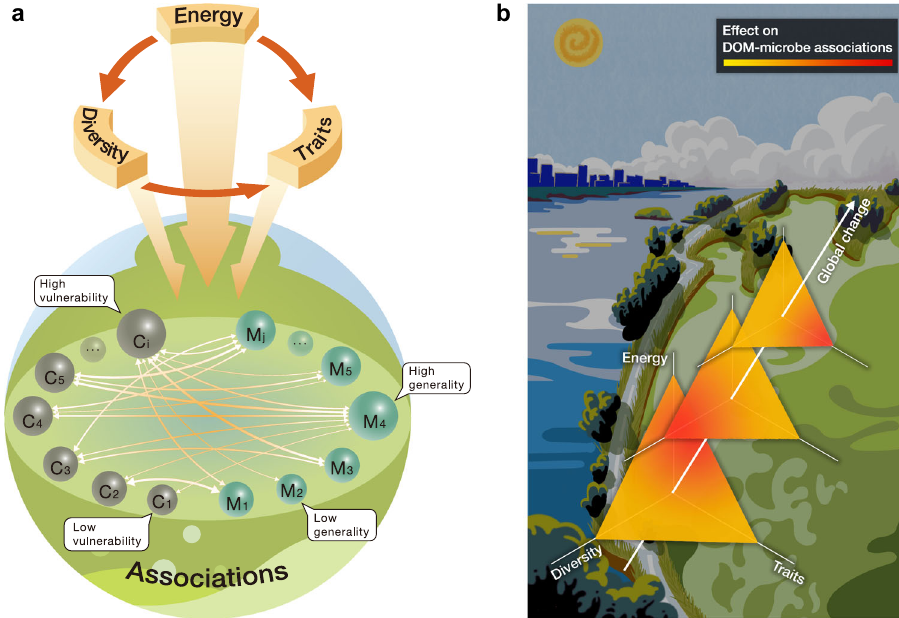
Fig. 1 A framework for studying the effects of global change on DOM-microbe associations. a DOM-microbe associations are affected by the three proximal drivers, namely energy supply and both the diversity and traits of DOM and microbes. The relationships among the three drivers and their in fl uences on the associations are shown with single-sided arrows. The DOM-microbe associations, indicated by double-sided arrows, are measured by bipartite interactions between DOM molecules (circles C 1 – C i ) and microbial taxa (circles M 1 – M j ). The size of circles indicates the abundance of DOM molecules or microbial species, and the width of arrows is the magnitude of associations. Commonly used indices summarise the specialization of individual molecule i and microbial species j , which describes the levels of “ vulnerability ” of DOM molecules and “ generality ” of microbial species. b Conceptual framework for understanding DOM-microbe associations under distal drivers such as global change via the three proximal drivers. For better 3D visualization, the sizes of triangles decrease towards the top-right, and the colour changes towards different corners of the triangles represent variations in the relative importance of different proximal drivers under a global change scenario. The background depicts the primary motivation of this study in examining distal drivers of climate change and eutrophication in Taihu Lake, China. The left and right waters indicate clean and cyanobacteria- dominated lake states, respectively, and are separated by a road having the shapes of western lakeshore and northern Zhushan and Meiliang Bays of Taihu Lake. We established fi eld microcosms on mountainsides by adding sediments collected from the lake centre, and designed nutrient levels and N/P ratio based on nutrient conditions of this lake 29